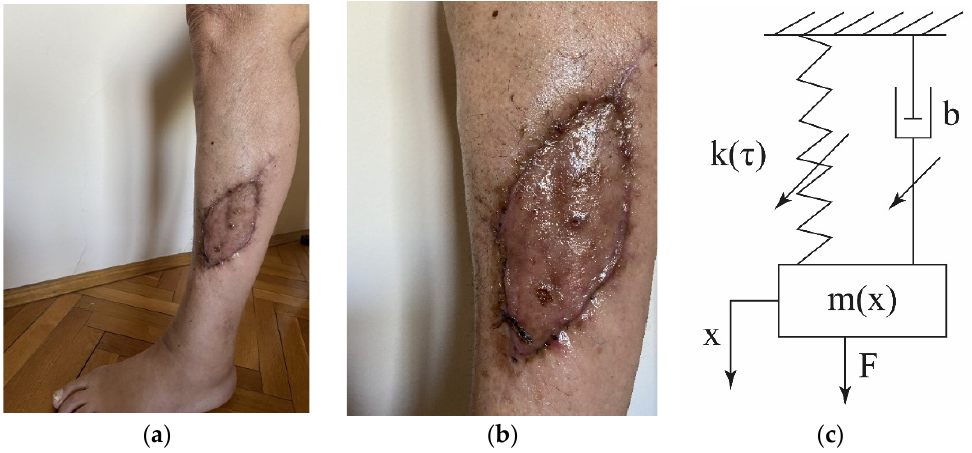
Figure 2. ( a ) Position of the graft skin, ( b ) shape of the grafted skin, ( c ) physical model.